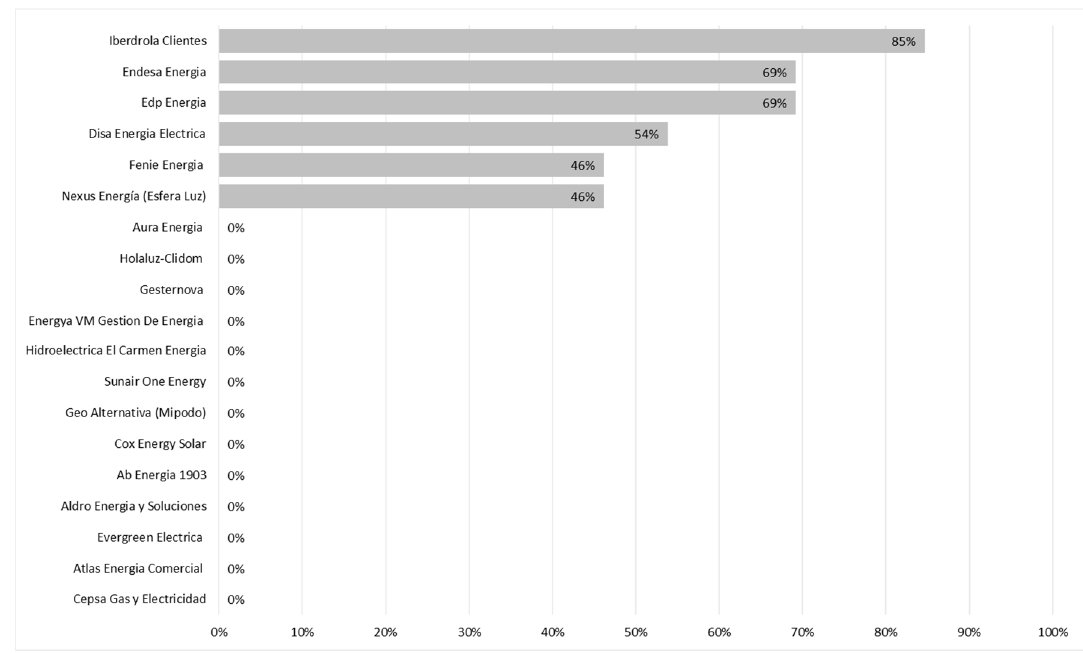
Figure 4. Global level of channel integration across free-market Spanish national electricity retailers.